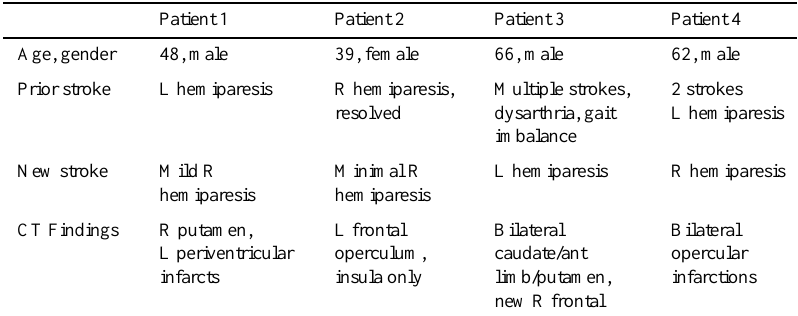
Fig. 1. CT scan cuts from Patient 1, showing a large hypodense area in the right putamen and overlying corona radiata, as well as a smaller area of infarction in the left periventricular area. Table 1 Clinical and CT scan features of 4